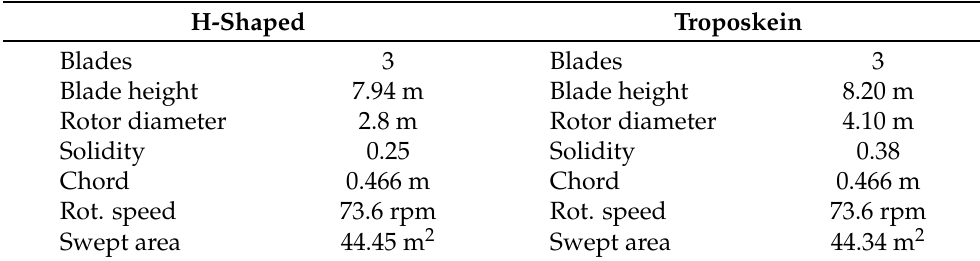
Table 6. Small scale ‘Savona’ VAWT geometric